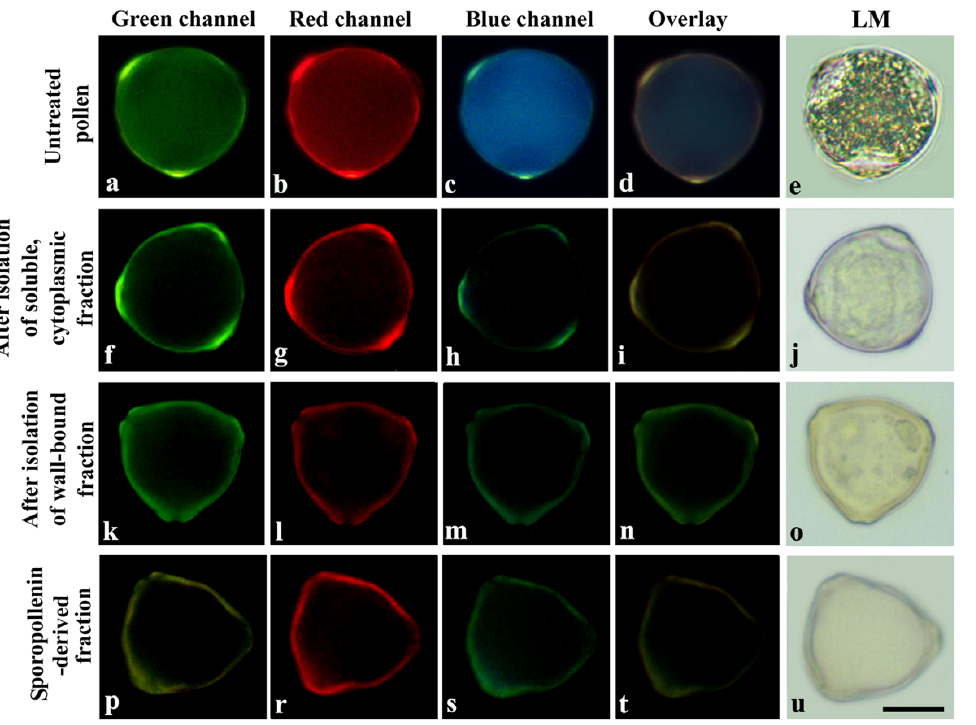
Figure 3. Representative fluorescence microscope images of pollen grains before and the after the isolation protocols. ( a ) Micrograph of untreated pollen under green channel; ( b ) Under red channel; ( c ) Under blue channel; ( d ) Under overlay of green, red and blue channel; ( e ) Under light microscope; ( f ) Micrograph of pollen after isolation of soluble, cytoplasmic fraction under green channel; ( g ) Under red channel; ( h ) Under blue channel; ( i ) Under overlay of green, red and blue channel; ( j ) Under light microscope; ( k ) Micrograph of pollen after isolation of wall-bound fraction under green channel; ( l ) Under red channel; ( m ) Under blue channel; ( n ) Under overlay of green, red and blue channel; ( o ) Under light microscope; ( p ) Pollen of sporopollenin-derived fraction under green channel; ( r ) Under red channel; ( s ) Under blue channel; ( t ) Under overlay of green, red and blue channel; ( u ) Under light microscope. Bar: 10 µm.